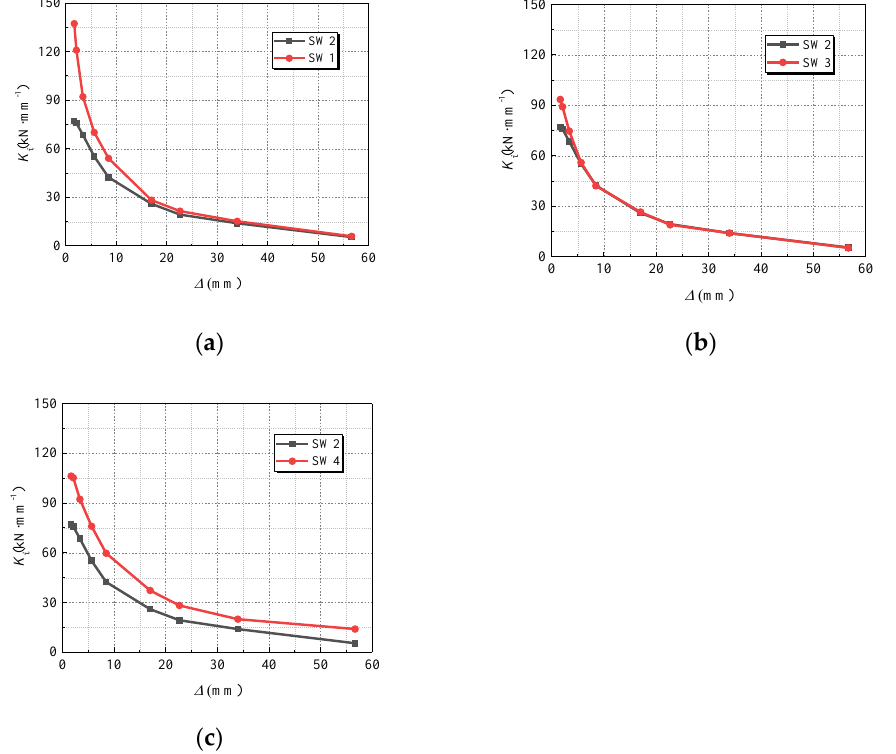
Figure 18. Stiffness degradation curves. ( a ) Fire exposure time; ( b ) Fire-retardant coating; ( c ) The width-thickness ratio.